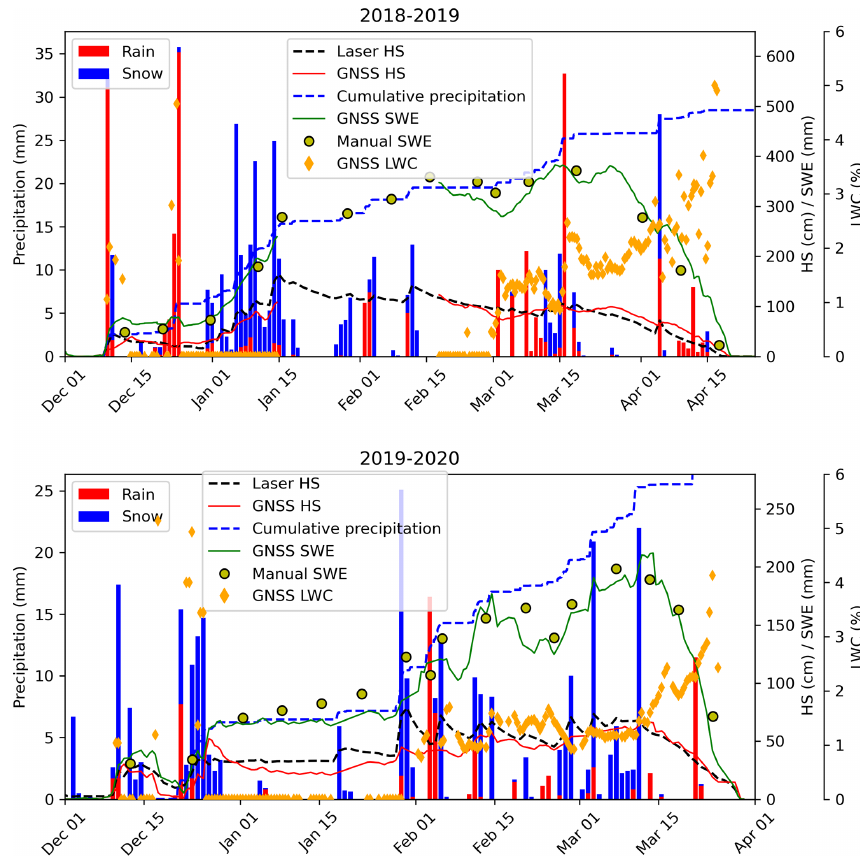
Figure B1. Seasonal evolution of GNSS-derived SWE and HS and corresponding reference data for Klosters. The blue columns correspond to precipitation in the form of snow; the red columns correspond to rain. Reference precipitation was measured by a pluviometer and classified as rain for air temperature T > 1.1 ◦ C and as snow for T ≤ 1.1 ◦ C. The various rain-on-snow events did not affect GNSS-derived SWE and